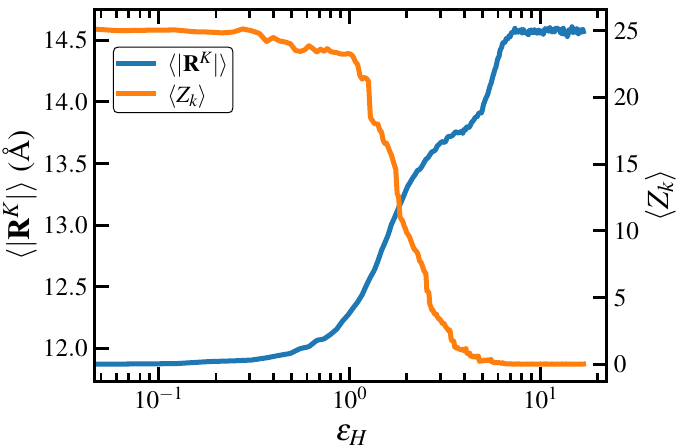
Figure 19. Mean value of the Kuhn segment magnitude, Z k , vs. Hencky strain for startup of UEF at De = (cid:104) (cid:105)